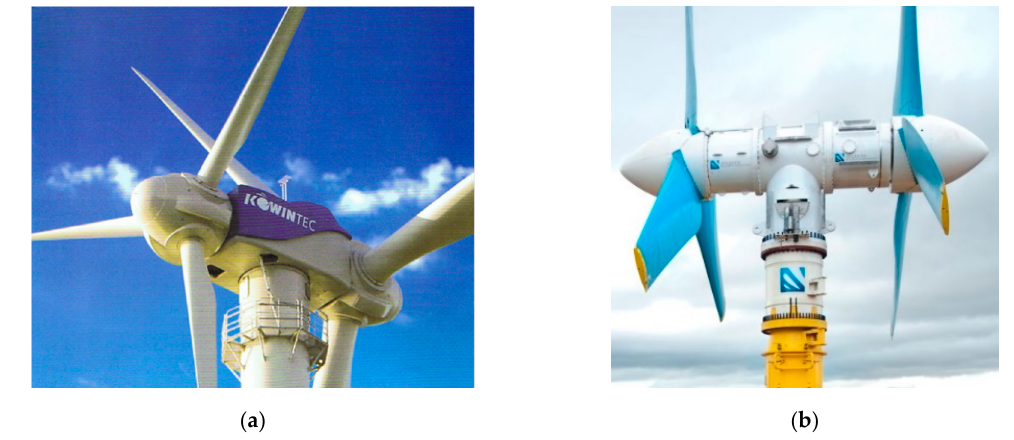
Figure 1. Dual rotor; ( a ) wind turbine of Kowintech Co. Ltd.; and ( b ) tidal turbine of SIMEC Atlantis Energy (formerly Atlantis Resources Corp.).